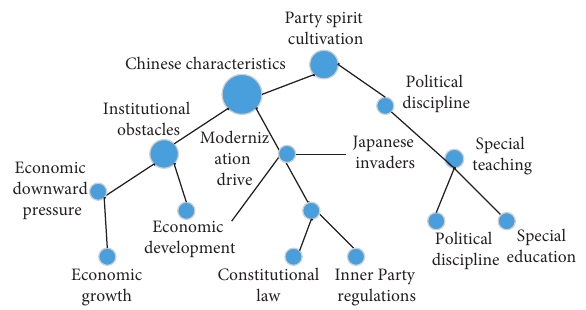
Figure 10: Keyword mapping of Marxist theory journals in